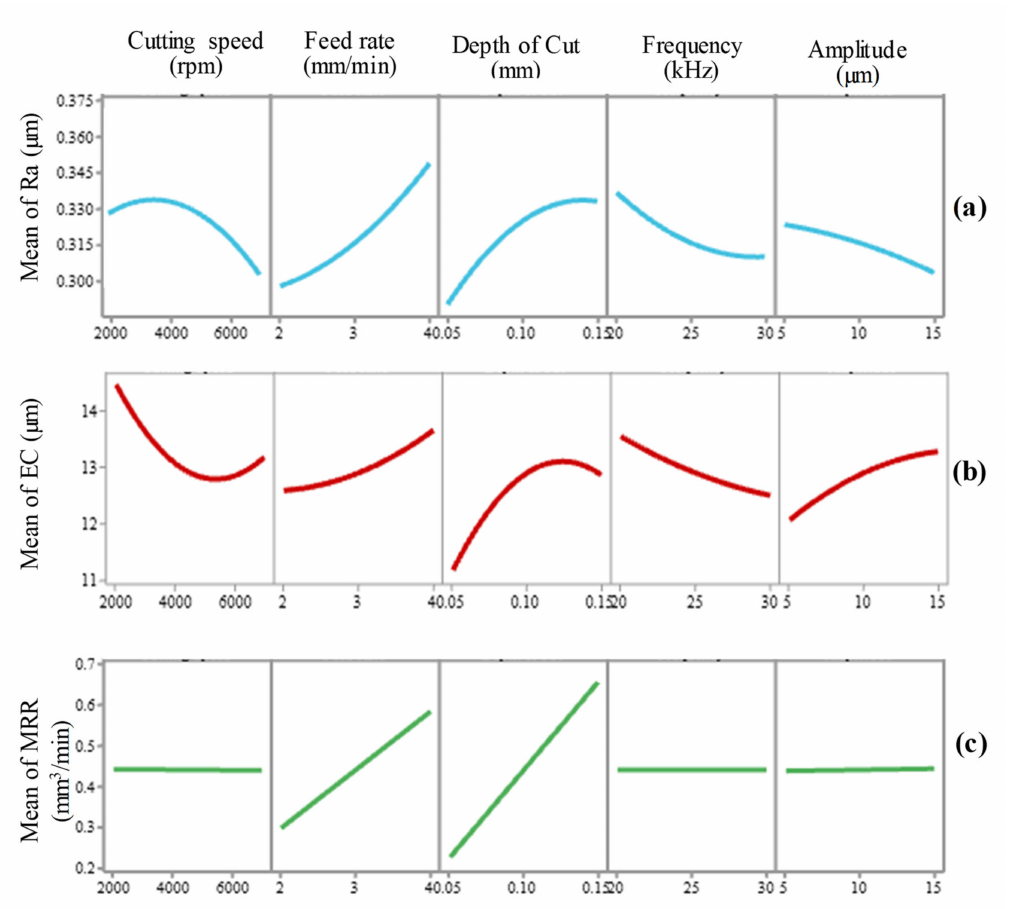
Figure 7. Main e ff ect plots of ( a ) Ra, ( b ) EC, and ( c )